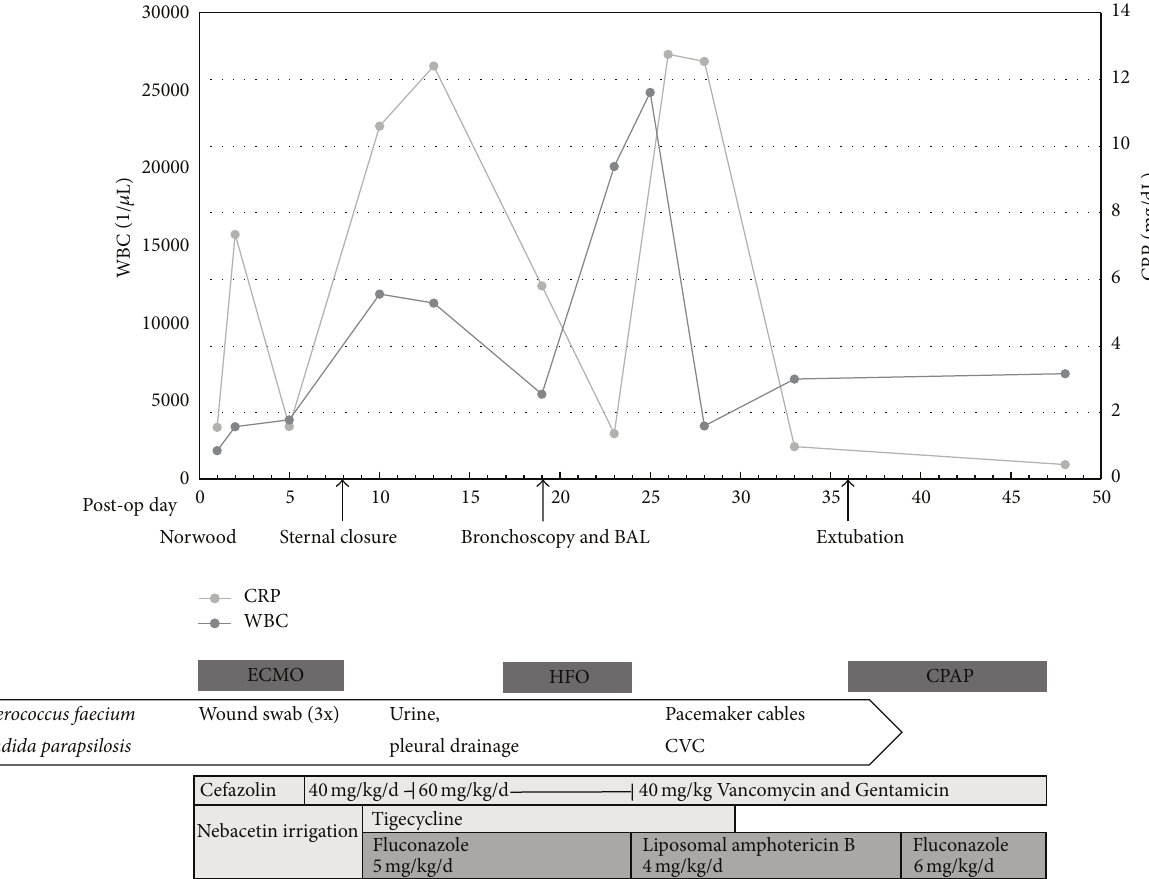
Figure 1: Hospital course. Serum C-reactive protein (CRP) level and leucocyte count (WBC) peaked after Norwood procedure, sternal closure, during pulmonary hemorrhage and invasive C. parapsilosis infection. Isolation of Enterococcus faecium and C. parapsilosis and mode and duration of treatment are shown. BAL: bronchoalveolar lavage, ECMO: duration of extracorporeal membrane oxygenation, HFO: duration of high-frequency oscillation, CPAP: duration of continuous positive airway pressure support, and CVC: central venous line.